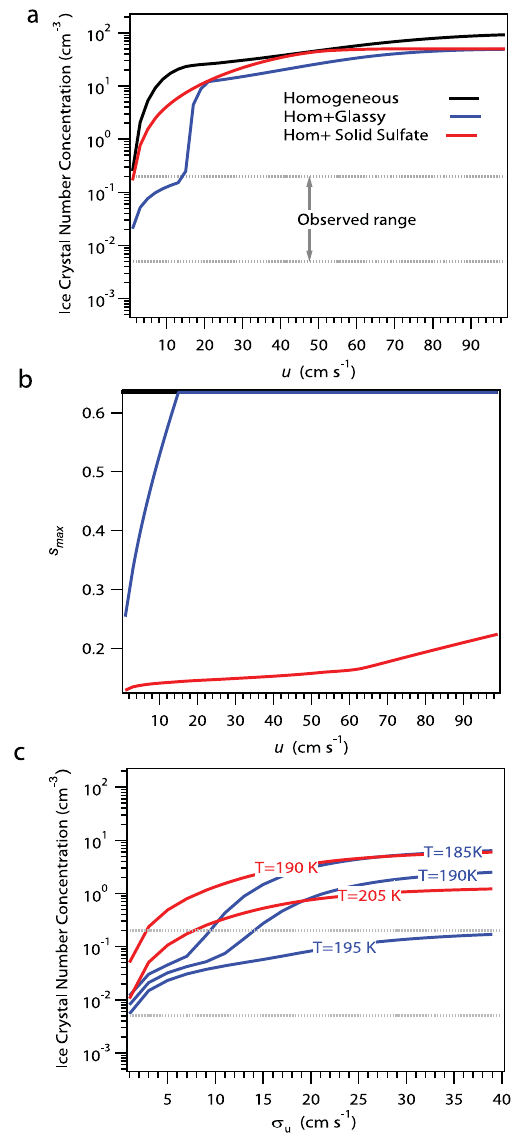
Fig. 3. Comparison between heterogeneous effects from solid am- monium sulfate (Abbatt et al., 2006) and glassy citric acid aerosol (Murray et al., 2010), using the analytical model of Barahona and Nenes (2009a) for homogeneous and heterogeneous freezing. (a) Maximum ice crystal concentration as a function of updraft velocity for a single freezing event. (b) Maximum supersaturation achieved for a single freezing event. (c) Ice crystal concentration averaged over a normal distribution of updraft velocities with zero mean and standard deviation σ u . The gray lines represent the range of N c typically observed (Kr¨amer et al.,